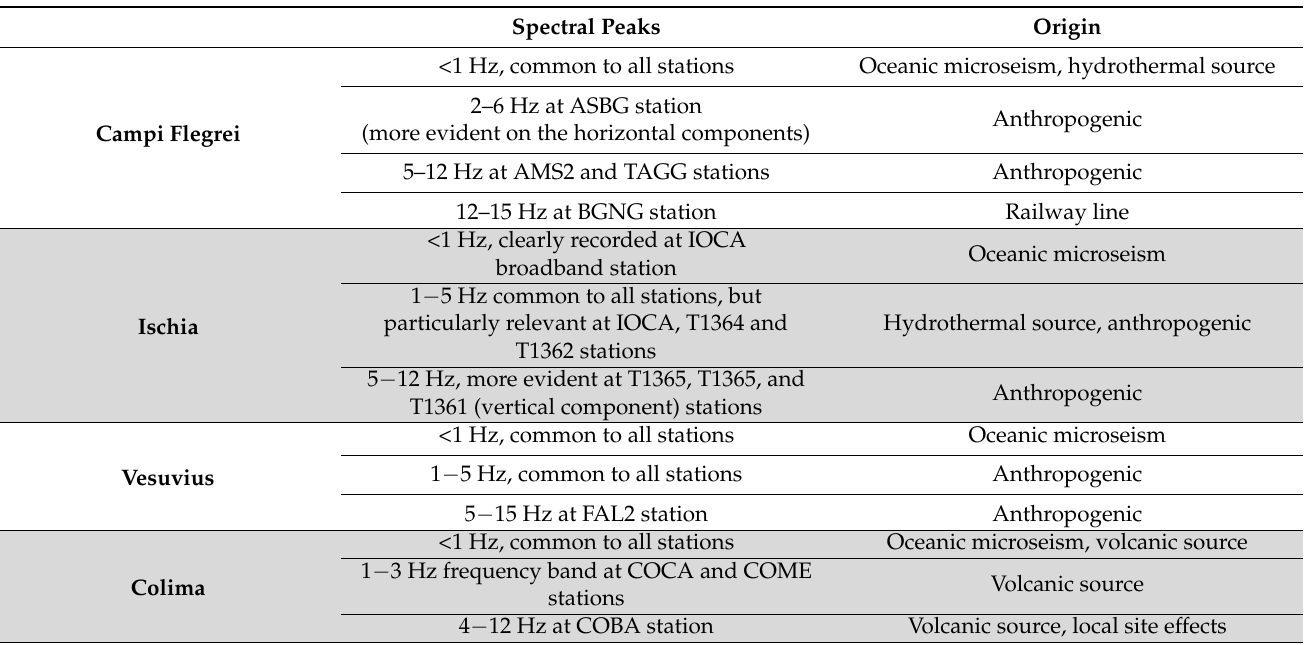
Table 1. Characterization of the frequency content of the seismic noise recorded at the Campi Flegrei, Ischia, Vesuvius, and Colima volcanoes. The interpretation of the origin of the spectral peaks is based on the works described in the Seismological Overview subsection.